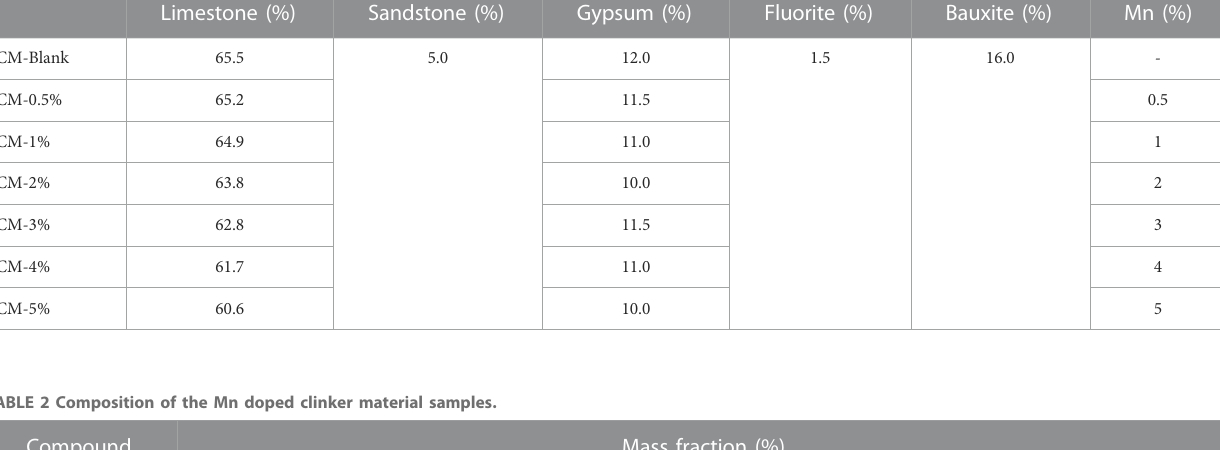
TABLE 1 The composition of the cement raw materials. Limestone (%)